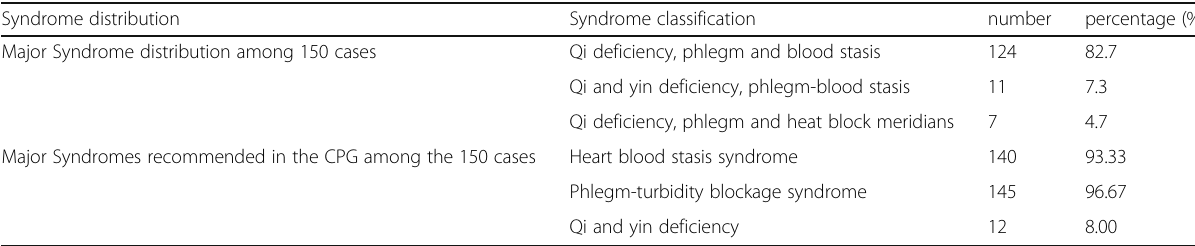
Table 6 Syndrome distribution among 150 cases Syndrome